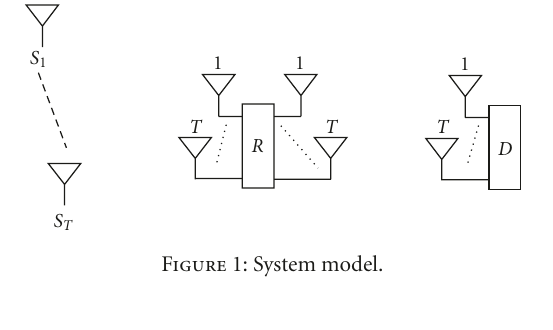
Figure 1: System model.